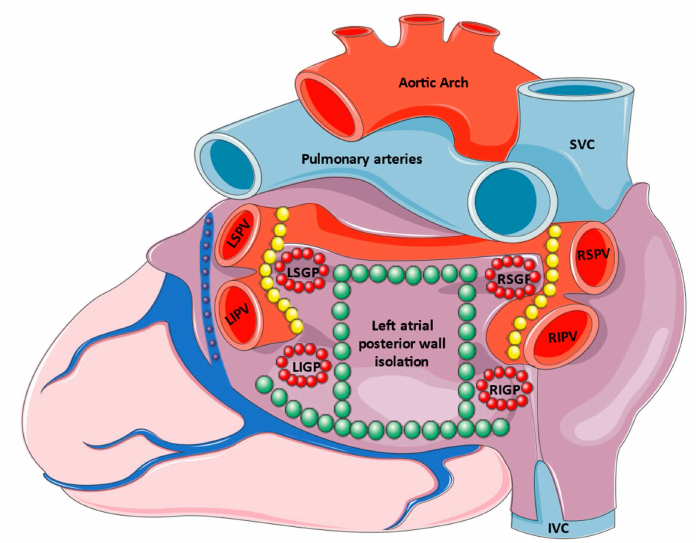
Figure 1. Radiofrequency catheter ablation of AF triggers. Although pulmonary vein isolation (yellow circles) remains the cornerstone of AF ablation, the ablation of the left atrial posterior wall (green circles), ganglionated plexuses (red circles), and retrograde ethanol infusion in the vein of Marshall (purple circles) are additional options that may be considered. IVC: inferior vena cava, LIPV: left inferior pulmonary vein, LIGP: left inferior ganglionated plexus, LSPV: left superior pulmonary vein, LSGP: left superior ganglionated plexus, RIGP: right inferior ganglionated plexus, RSGP: right superior ganglionated plexus, RIPV: right inferior pulmonary vein, RSPV: right superior pulmonary vein, SVC: superior vena